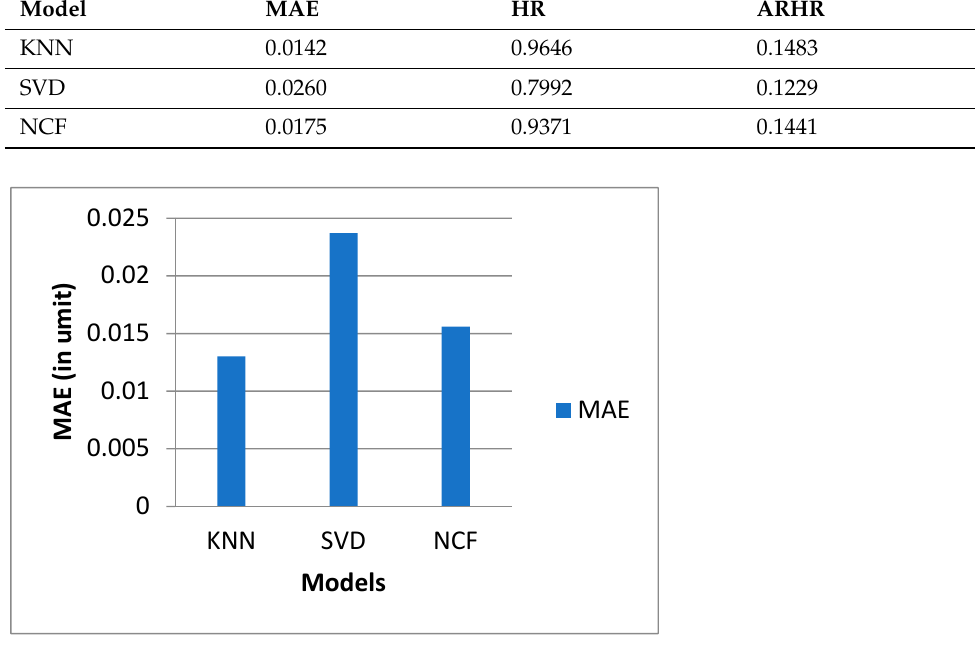
Figure 5. Performance results of different models in terms of MAE in 60:40 training–testing sce- nario.